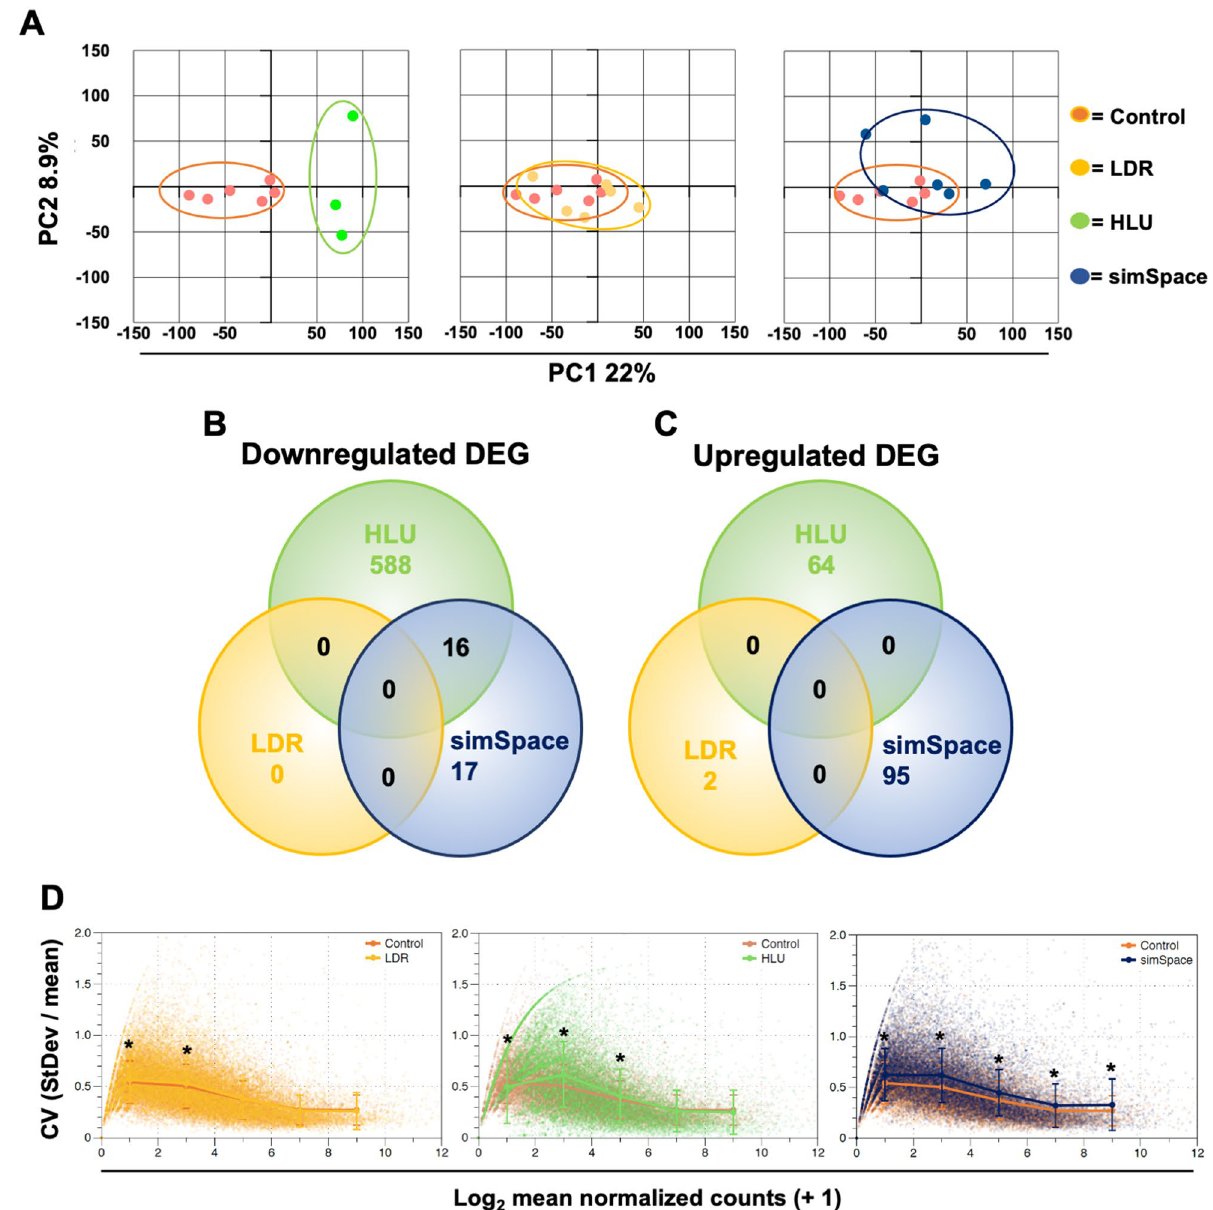
Figure 1. Post-simulated spaceflight conditions display distinct transcriptomics. Mice spleens collected 7-days following hindlimb unloading (HLU, green), low-dose irradiation (LDR, 0.04 Gy total dose, yellow), and combined HLU and LDR (simSpace, blue) for 21-days, compared to controls (orange). Principal component analysis (PCA) plot indicated for each condition ( A ). Venn diagrams for downregulated ( B ) and upregulated ( C ) genes. ( D ) Calculated coefficient of gene expression variation (CV) per gene plotted against the Log 2 of the mean normalized count for that gene (+ 1) in each group. A one-way ANOVA with post hoc pairwise t tests (using step-down method, Sidak for adjusting p values) was performed in ( D ). Data represents n = 3–6 per